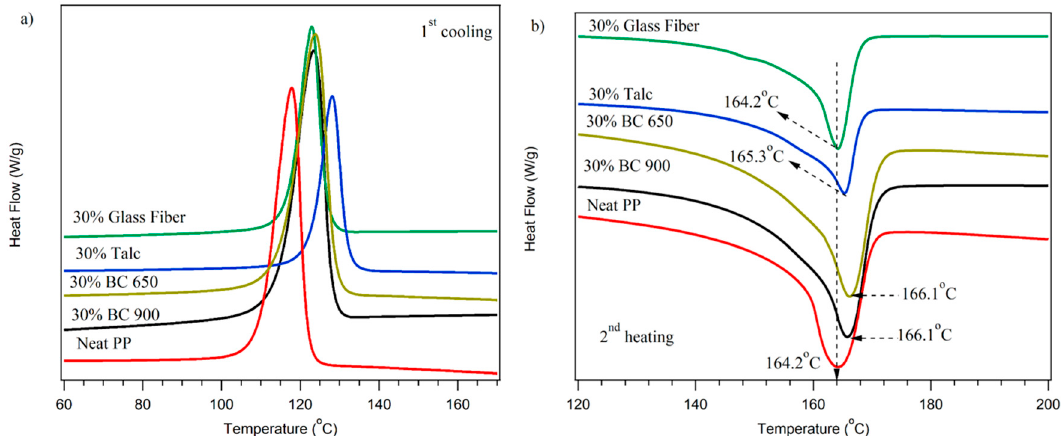
Figure 3. DSC 1st cooling ( a ) and 2nd heating ( b ) of PP and PP-filler composites. Table 2. Thermal properties of neat PP and PP-filler composites from TGA and DSC curves a. Code